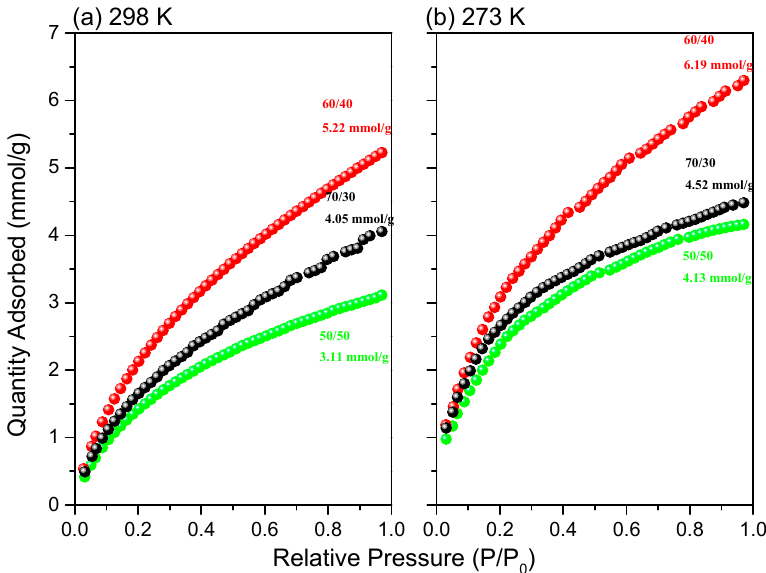
Figure 6. Raman spectra of mesoporous carbons templated by various concentrations of LEL triblock copolymer.